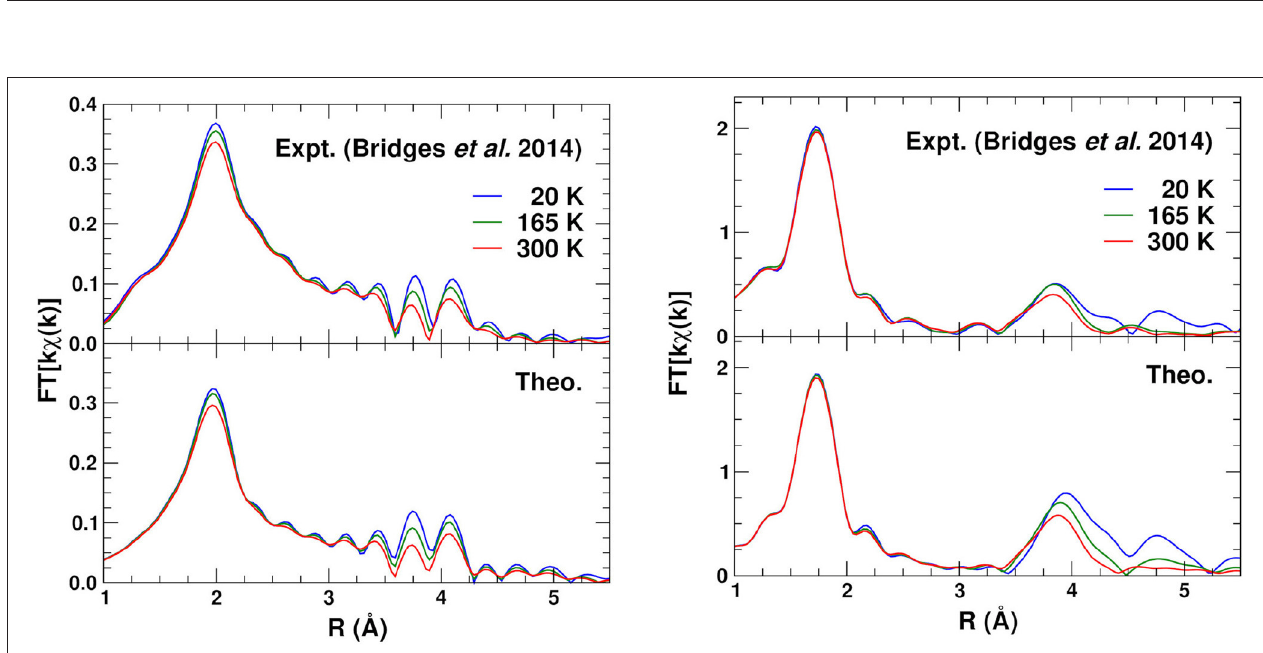
FIGURE 7 | Comparison of the experimental (Bridges et al., 2014) and theoretical EXAFS fine structure k χ ( k ) at 20, 165, and 300 K for the Zr K edge (left) and the W L 3 edge (right). The theory used the experimental lattice constant with optimized MSRDs to avoid small phase shifts due to the 1% error in the optimized PBEsol structure.